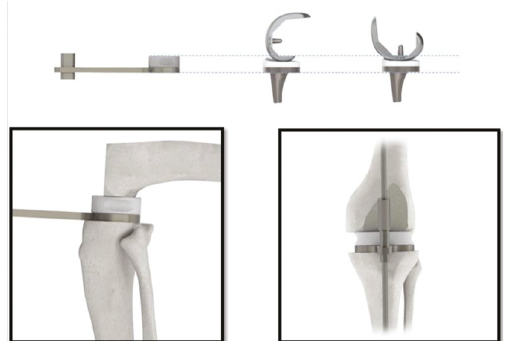
Figure 2: The spacer block system provided in the instrumentation of the Balanced Knee System used in this